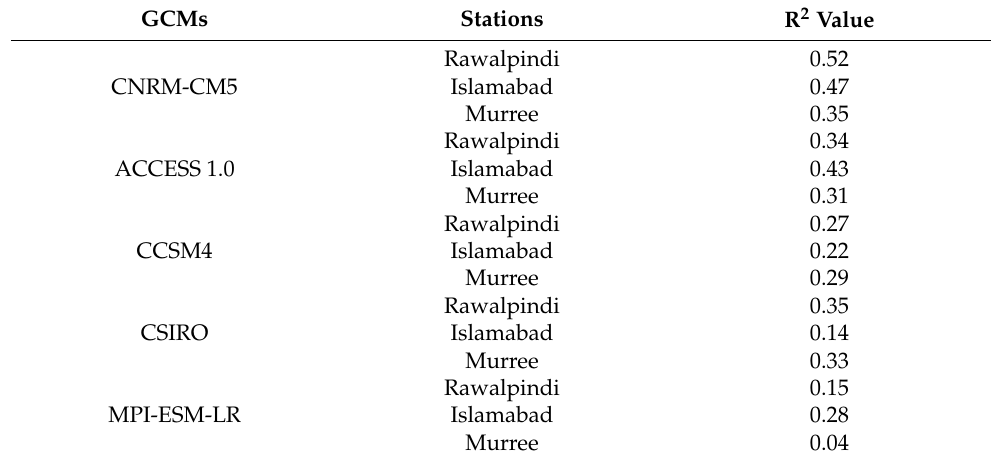
Table 1. R 2 values of selected GCMs with respect of climatic stations. GCMs